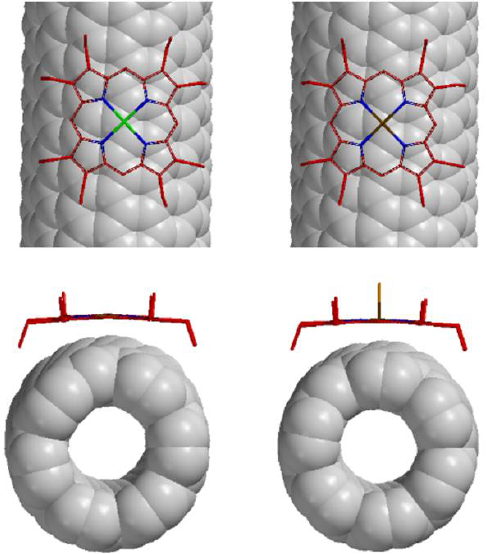
Figure 9. Computer-generated molecular modeling of the complex structures: side views (top) and views along the SWNT axis (bottom) of 1:1 complexes of ZnOEP and (7,6)-SWNT (left) and MnOEP and (7,6)-SWNT